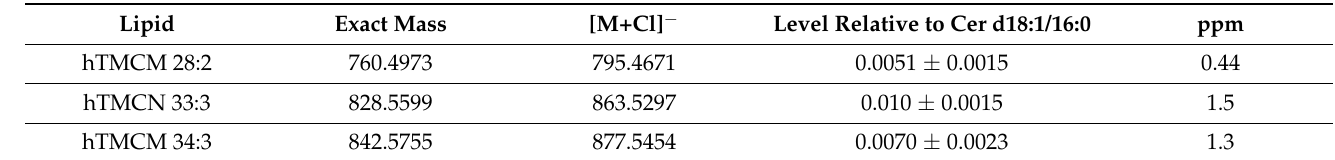
Table 1. The chloride adducts of bacterial membrane trehalose monohydroxylcorynomyclates moni- tored in the tear film of cattle with pink